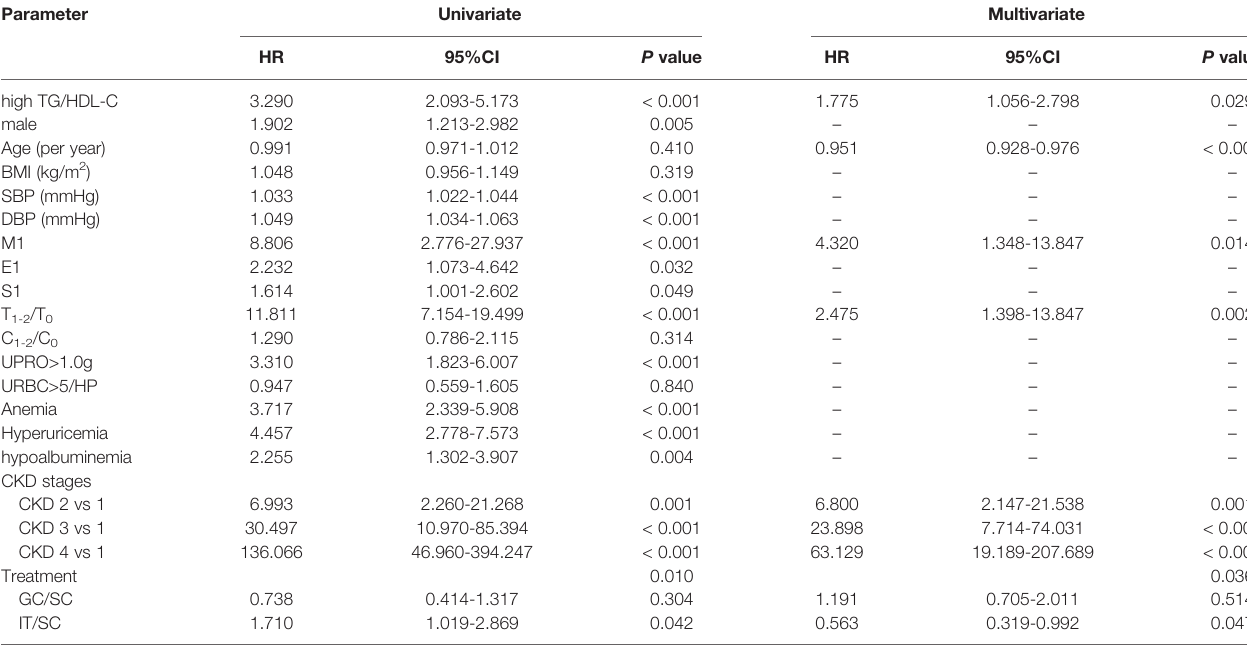
TABLE 4 | Analysis of factors associated with renal outcomes in model 3 (demographics+ clinical indicators+ pathological features+ TG/HDL-C).